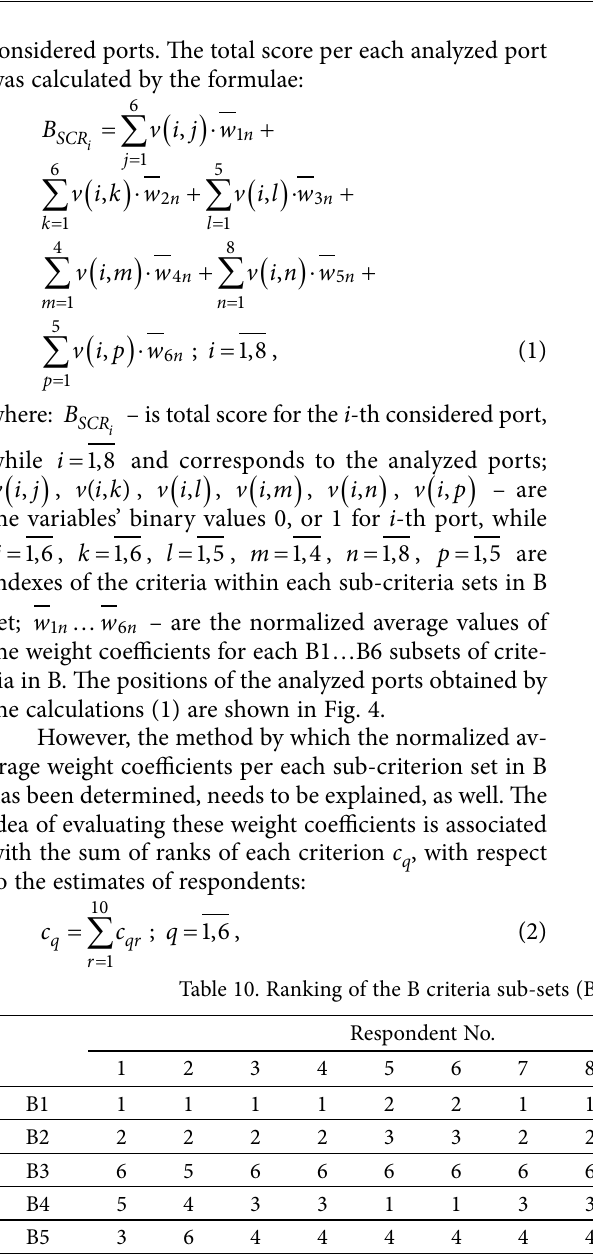
Sum of ranks qn w